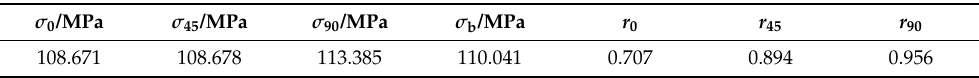
Table 7. Mechanical properties of material 5754O.